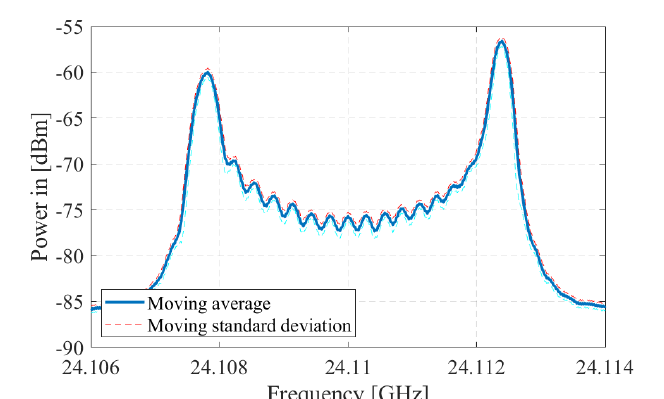
Figure 13. The spectrum obtained by modulating the voltage controlled oscillator (VCO) of a K-MC3 radar module with two alternating frequencies.